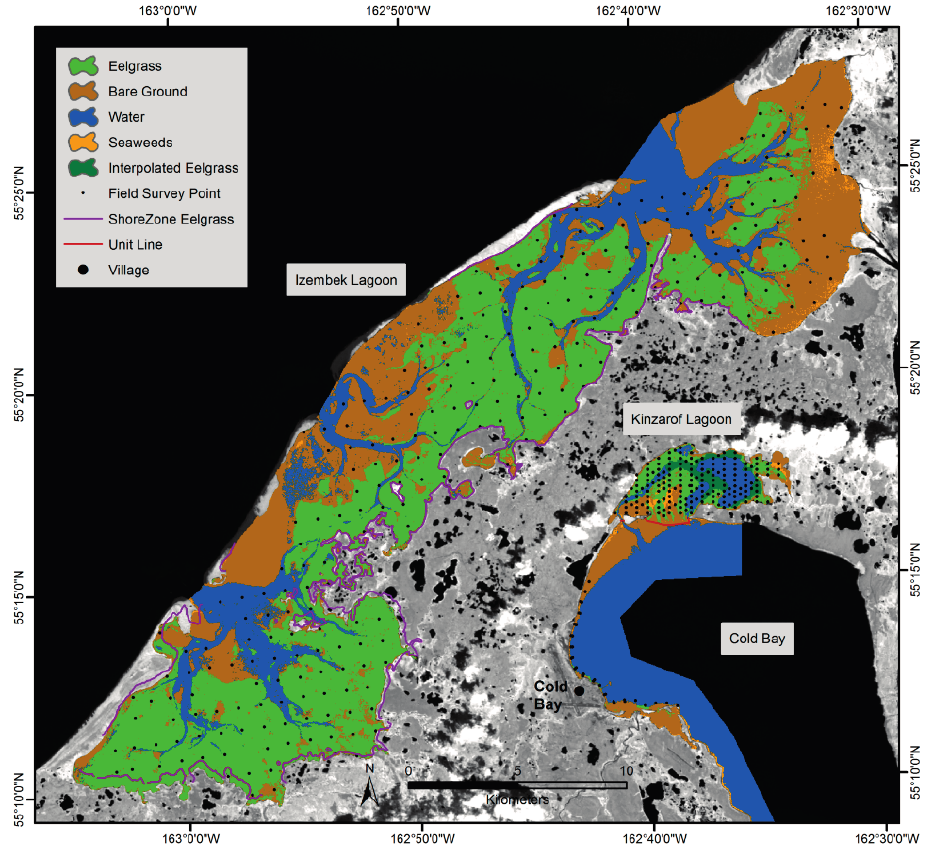
Figure 4. Distribution of eelgrass and other classified habitats as derived from Landsat imagery (displayed as a black/grayscale backdrop) and field survey points in Izembek Lagoon, Kinzarof Lagoon and northwest Cold Bay. Also shown, highlighted in purple, is the linear coastal eelgrass distribution derived by ShoreZone.